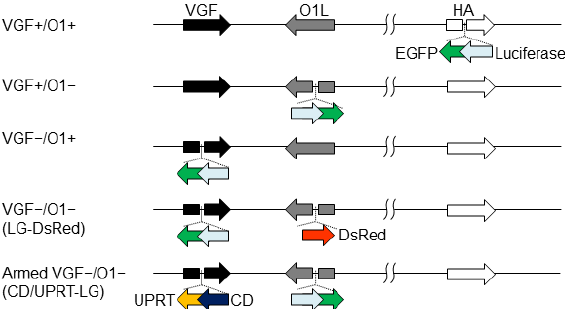
Figure 1. Recombinant vaccinia viruses genetically engineered by the deletion of viral genes and expression of transgenes. Vaccinia growth factor ( VGF )- and/or O1 -deleted viruses were generated through the insertion of a gene cassette expressing luciferase-fused EGFP (LG) and/or DsRed into the VGF and O1 gene loci. VGF - and O1 -deleted armed virus was developed via the insertion of a gene cassette expressing cytosine deaminase-fused uracil phosphoribosyl transferase (CD/UPRT) and LG into the VGF and O1 gene loci, respectively. VGF - and O1 -intact control viruses were constructed through the insertion of a gene cassette expressing LG into the HA gene loci.